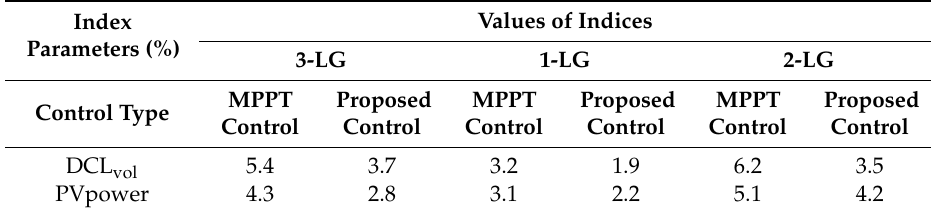
Table 1. Performance index enhancement with the proposed control scheme for symmetrical and asymmetrical